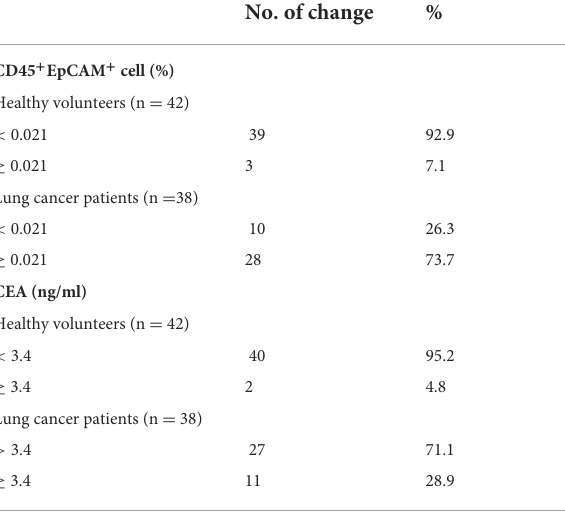
TABLE 3 Comparative analysis of CEA serum level and CD45 + EpCAM + cell ratio in PBMCs from health volunteers and lung cancer patients. No. of